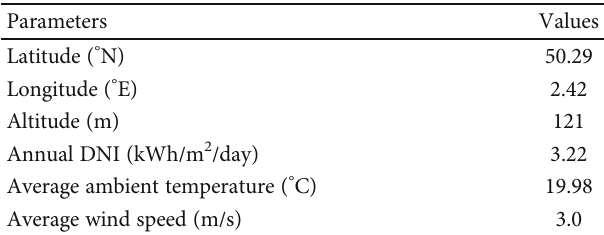
Table 9: Selected site geographical data.